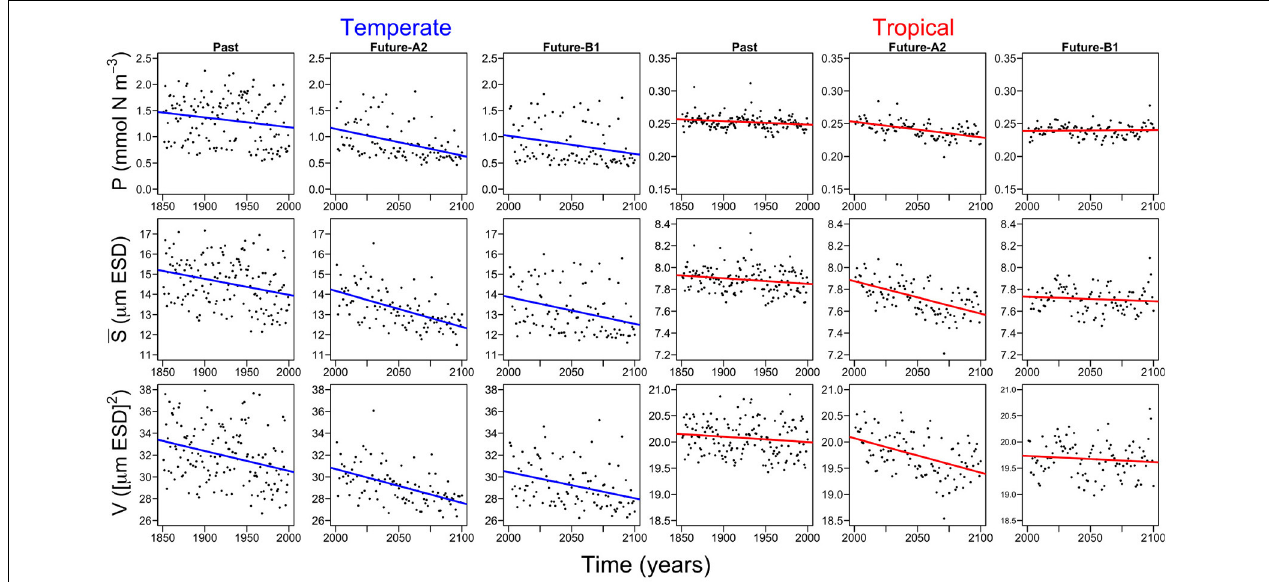
FIGURE 5 | Probabilistic model fits of the annual trends of the phytoplankton state variables for temperate and tropical regions and for the three different time periods (i.e., past, future-A2, and future-B1). P is